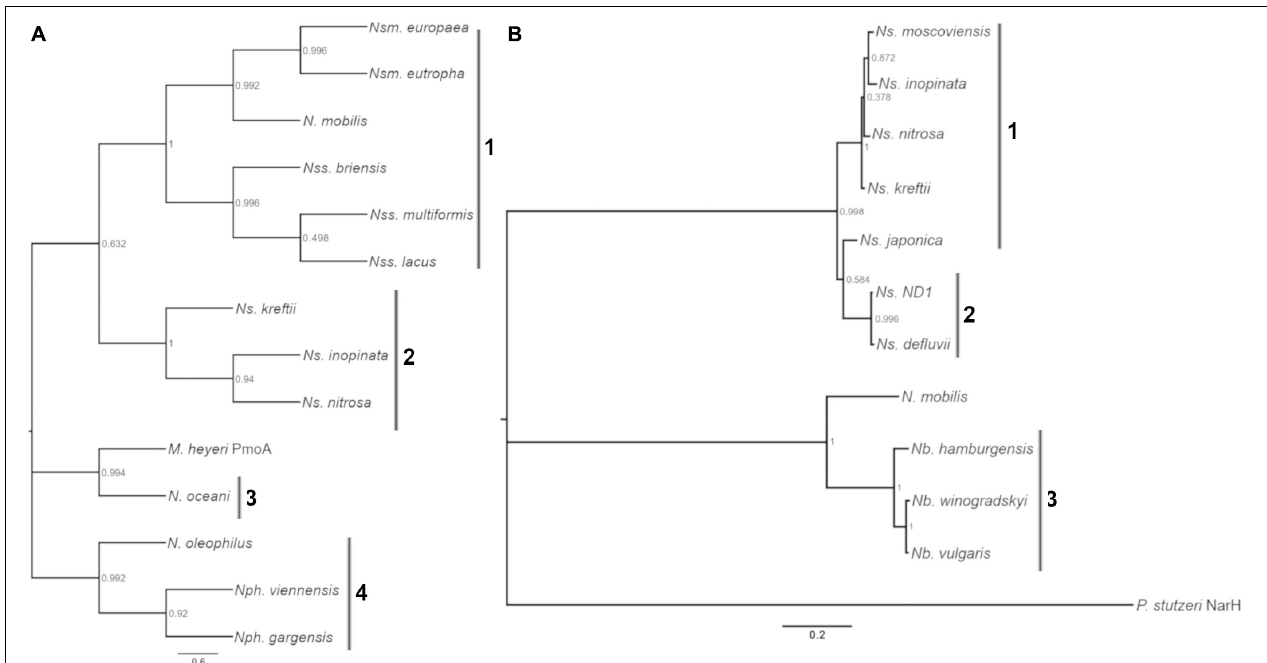
FIGURE 1 | Evolutionary history of AmoA and NxrA. Phylogenetic trees of AmoA (A) and NxrA (B) homologs from nitrifiers and other bacteria. (A) Numbered bars indicate clades: 1, Nitrosomonas and Nitrosospira , 2, Comammox Nitrospira , 3, Nitrosococcus , and 4, AOA. (B) Numbered bars indicate clades: 1, Nitrospira lineage II, 2, Nitrospira Lineage I, and 3, Nitrobacter . The scale bar indicates the mean number of substitutions per site. Bootstrap values from 500 resamplings are rounded to two digits. The protein name of the homolog follows the genus and species, if not AmoA or NxrA. Strain designation and accession numbers can be found in Supplementary Datasets 1 , 2